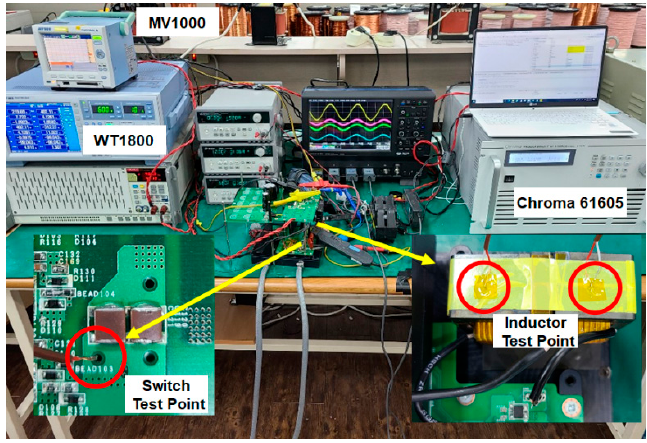
Figure 10. Picture of the experimental platform.